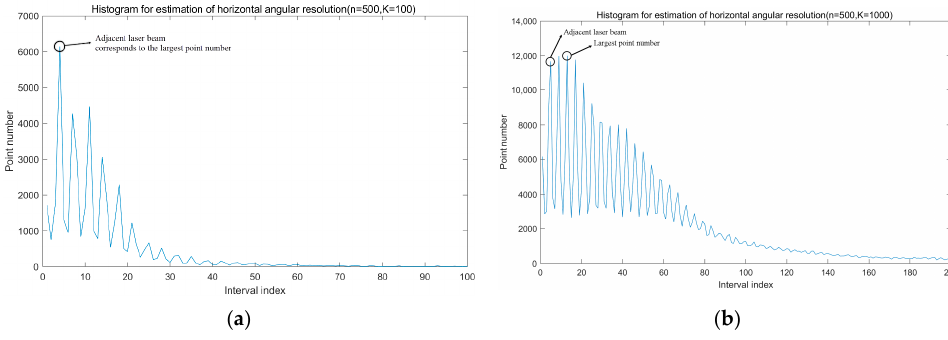
Figure 11. The histogram in terms of different K values. ( a ) K = 100; ( b ) K = 1000.